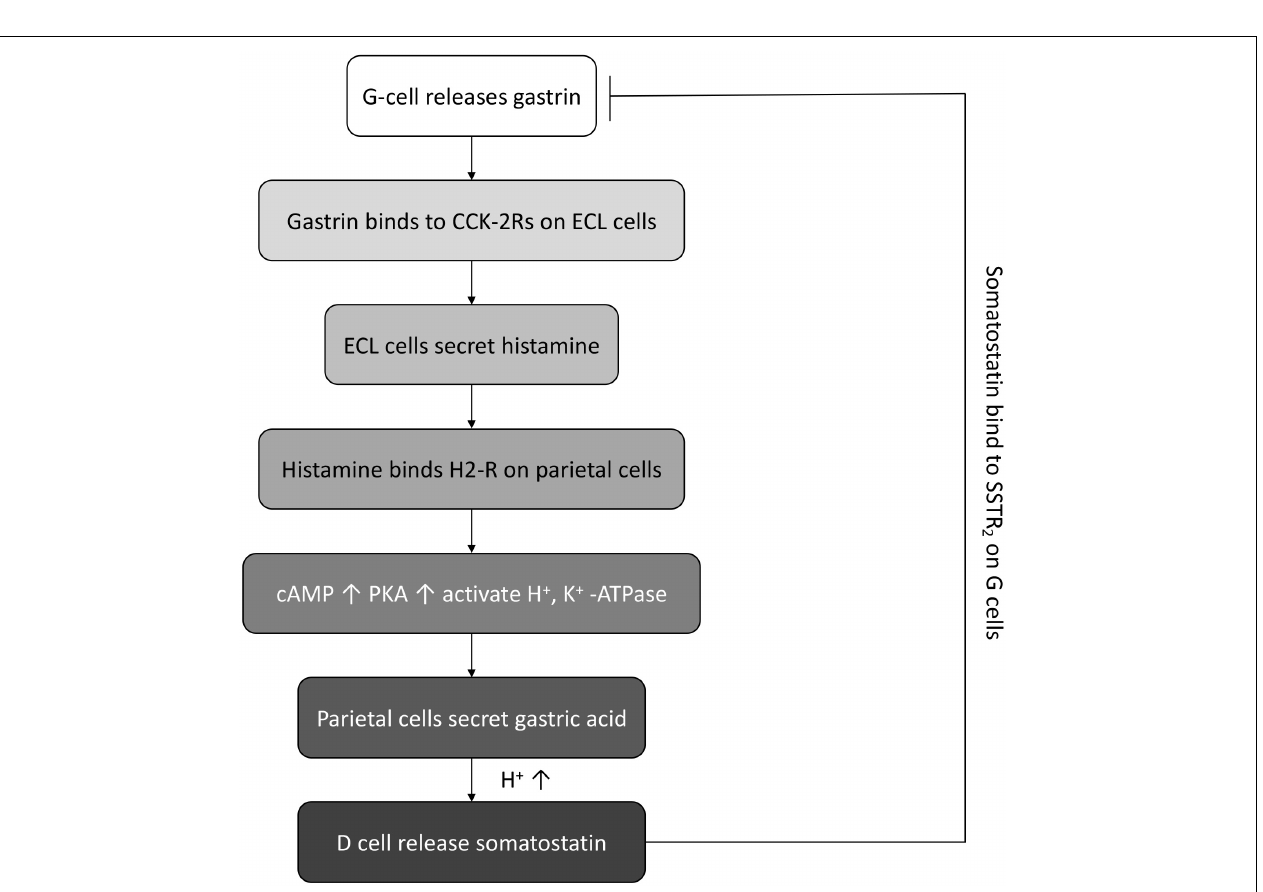
FIGURE 3 | The schematic diagram of normal feedback loop between gastrin, gastric acid, and somatostatin.